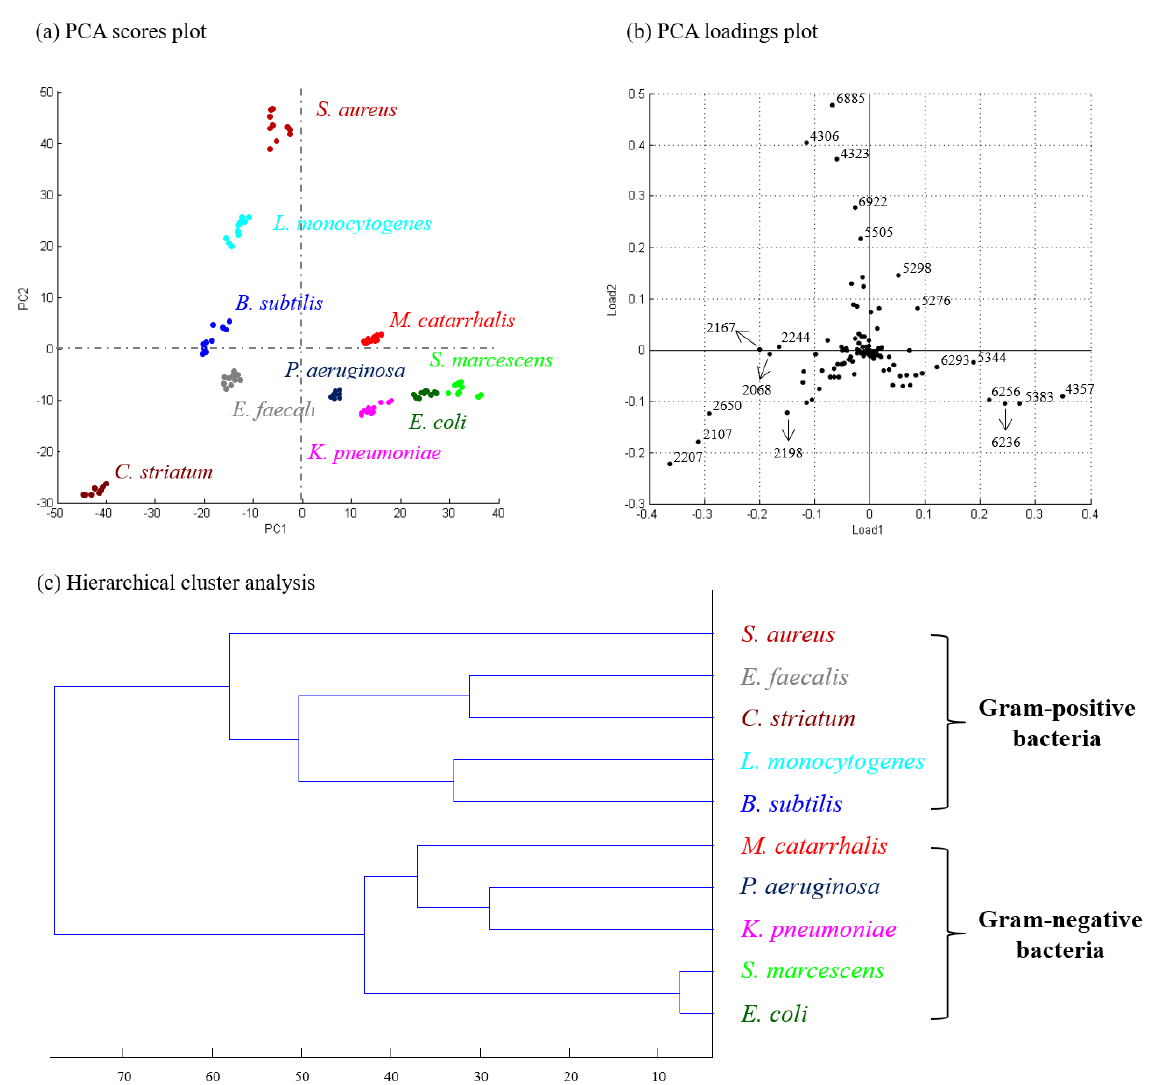
Figure 7. The PCA score plot ( a ), PCA loading plot ( b ), and HCA ( c ) of the protein ion signals on the MALDI-TOF mass spectra of extracts from 10 bacterial species. Each colony was determined by 10